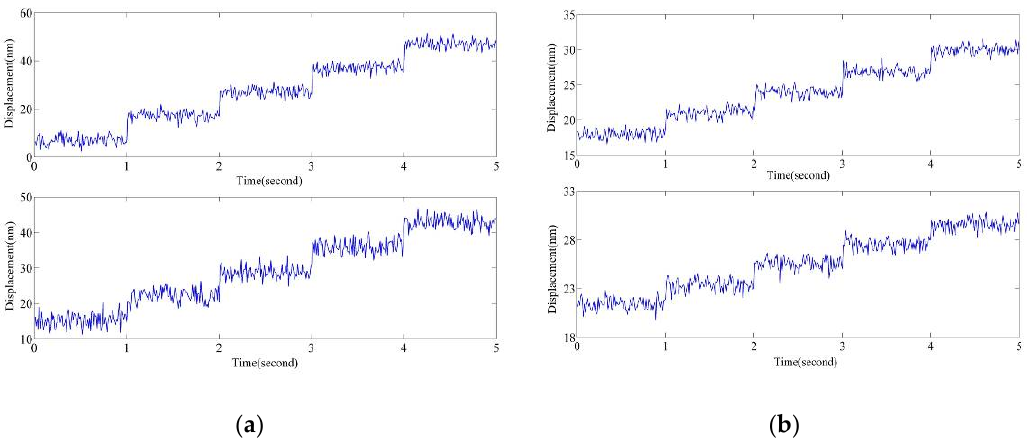
Figure 8. Experimental results of interferometer evaluating PM and AM performance of EMLMA. ( a ) Measurement resolution before the AM. ( b ) The measurement resolution after the AM.